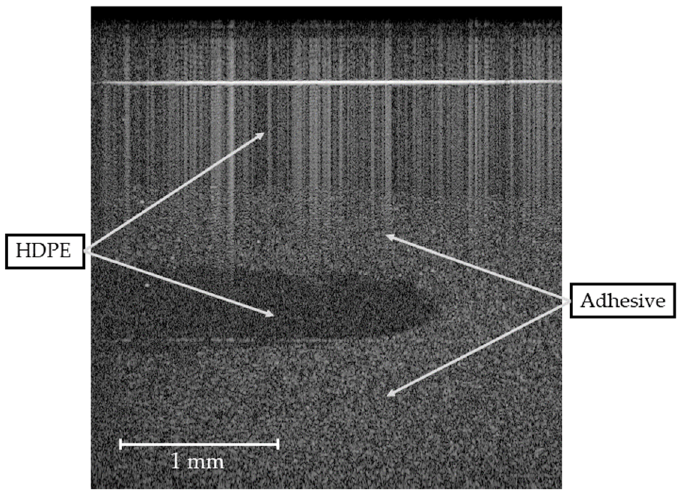
Figure 16. B-scan showing interpenetration of adhesive and HDPE, which leads to mixing of